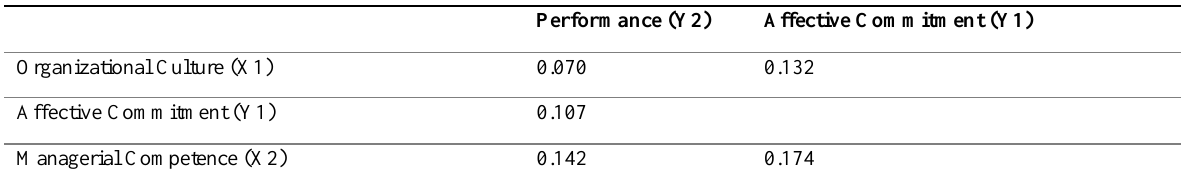
Table 19: Effect Size Value